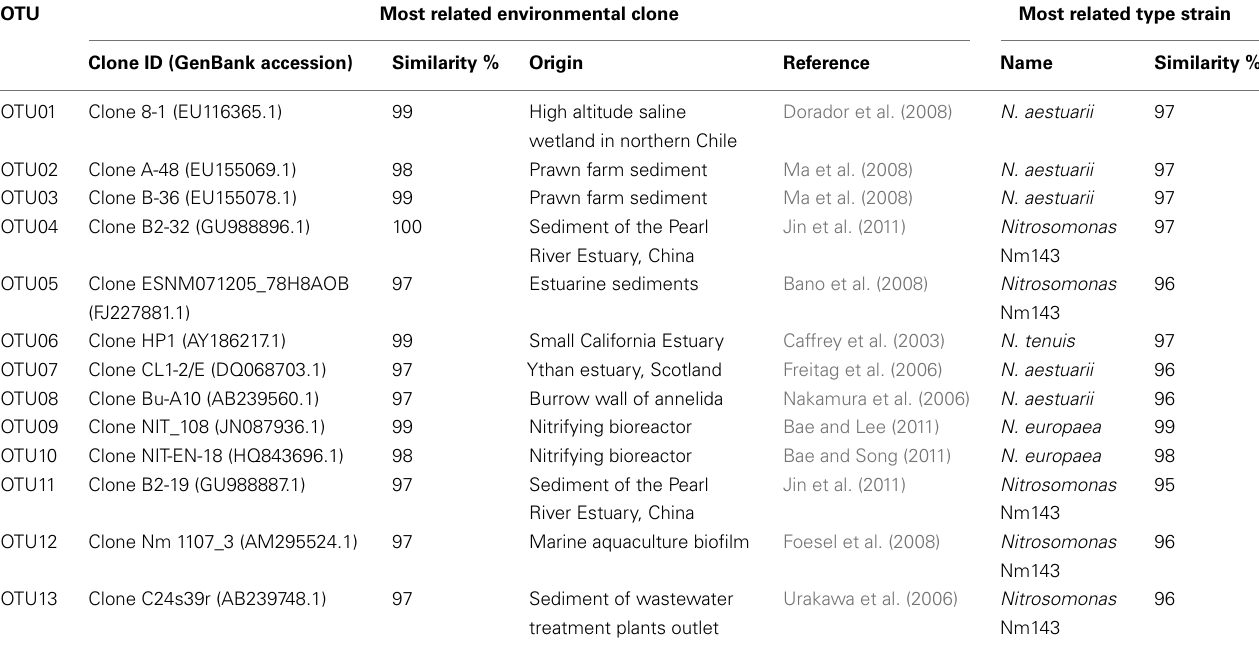
Table 2 | Operational taxonomical units (OTUs) affiliated to ammonia-oxidizing betaproteobacteria recovered from mangrove soils and their most close relatives as retrieved from BLAST search.